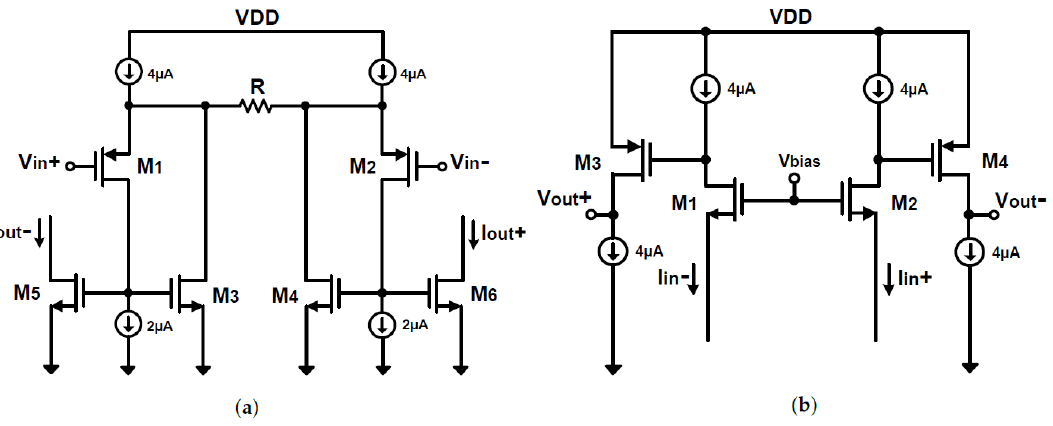
Figure 10. Schematic of the pseudo-differential G m - C loop filter: ( a ) transconductor; and ( b ) the amplifier used in the Miller